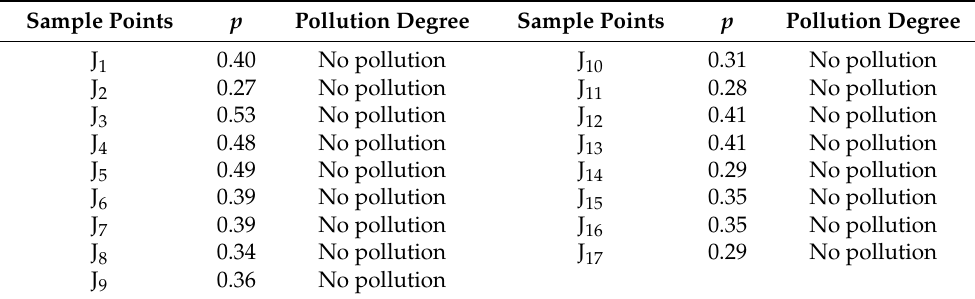
Table 3. Nemerow comprehensive indexes of soil pollution from heavy metals. Sample